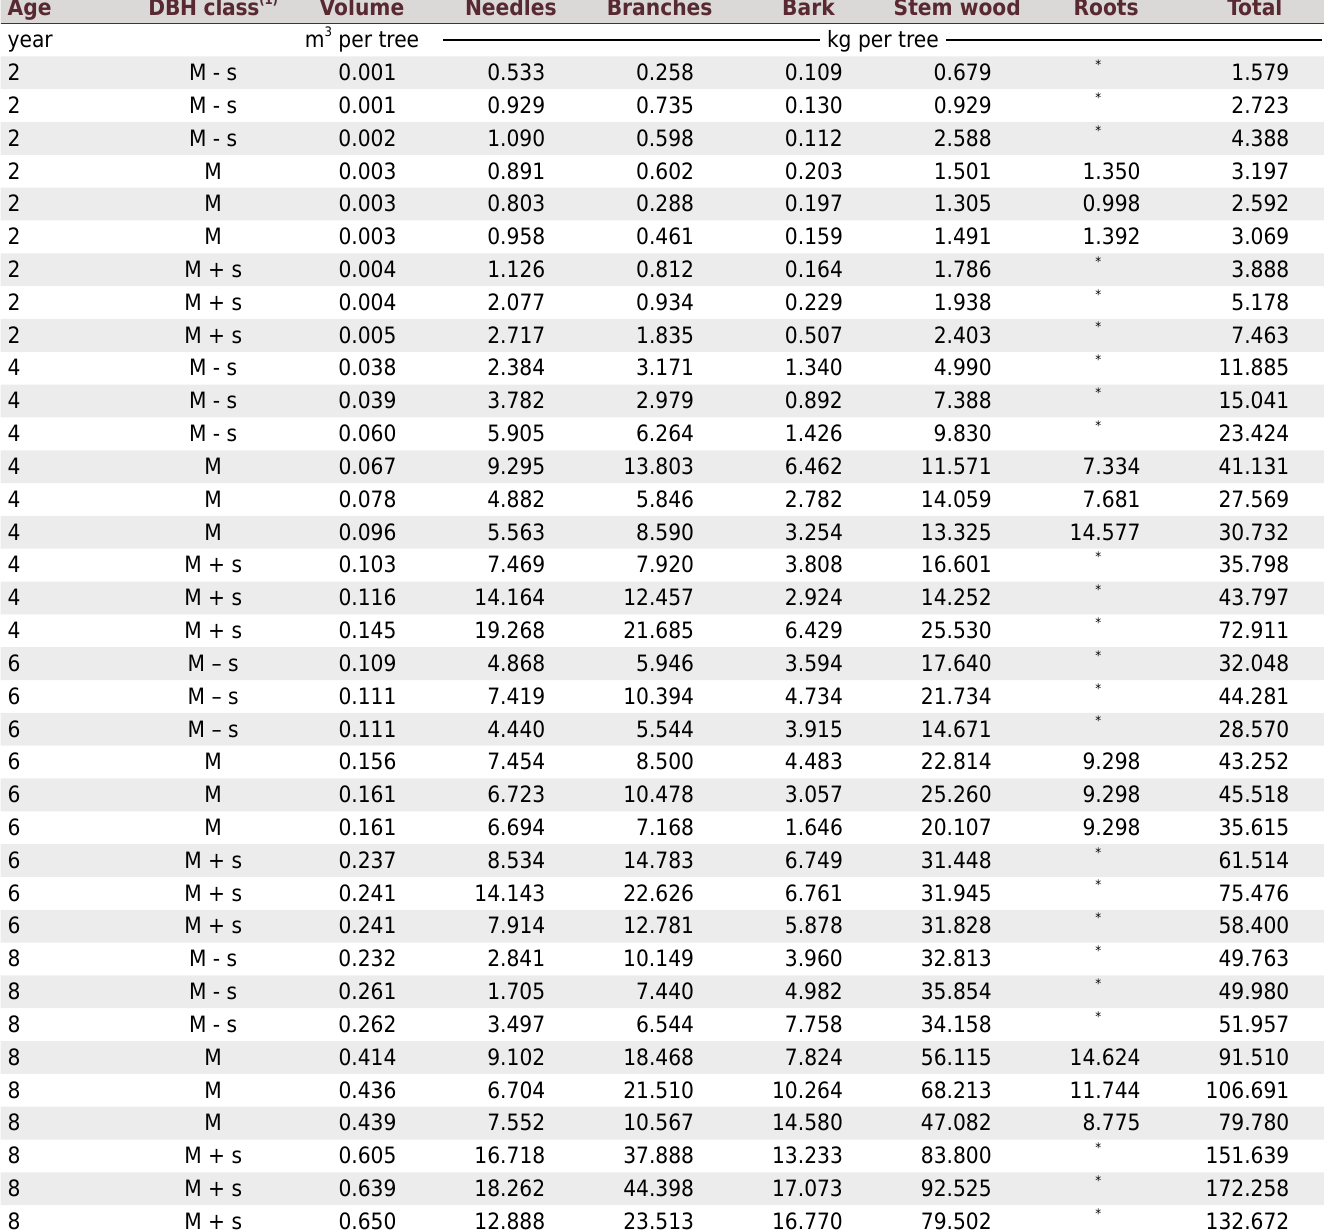
Table 2. Trunk volume and biomass partitioning in Pinus taeda trees in southern